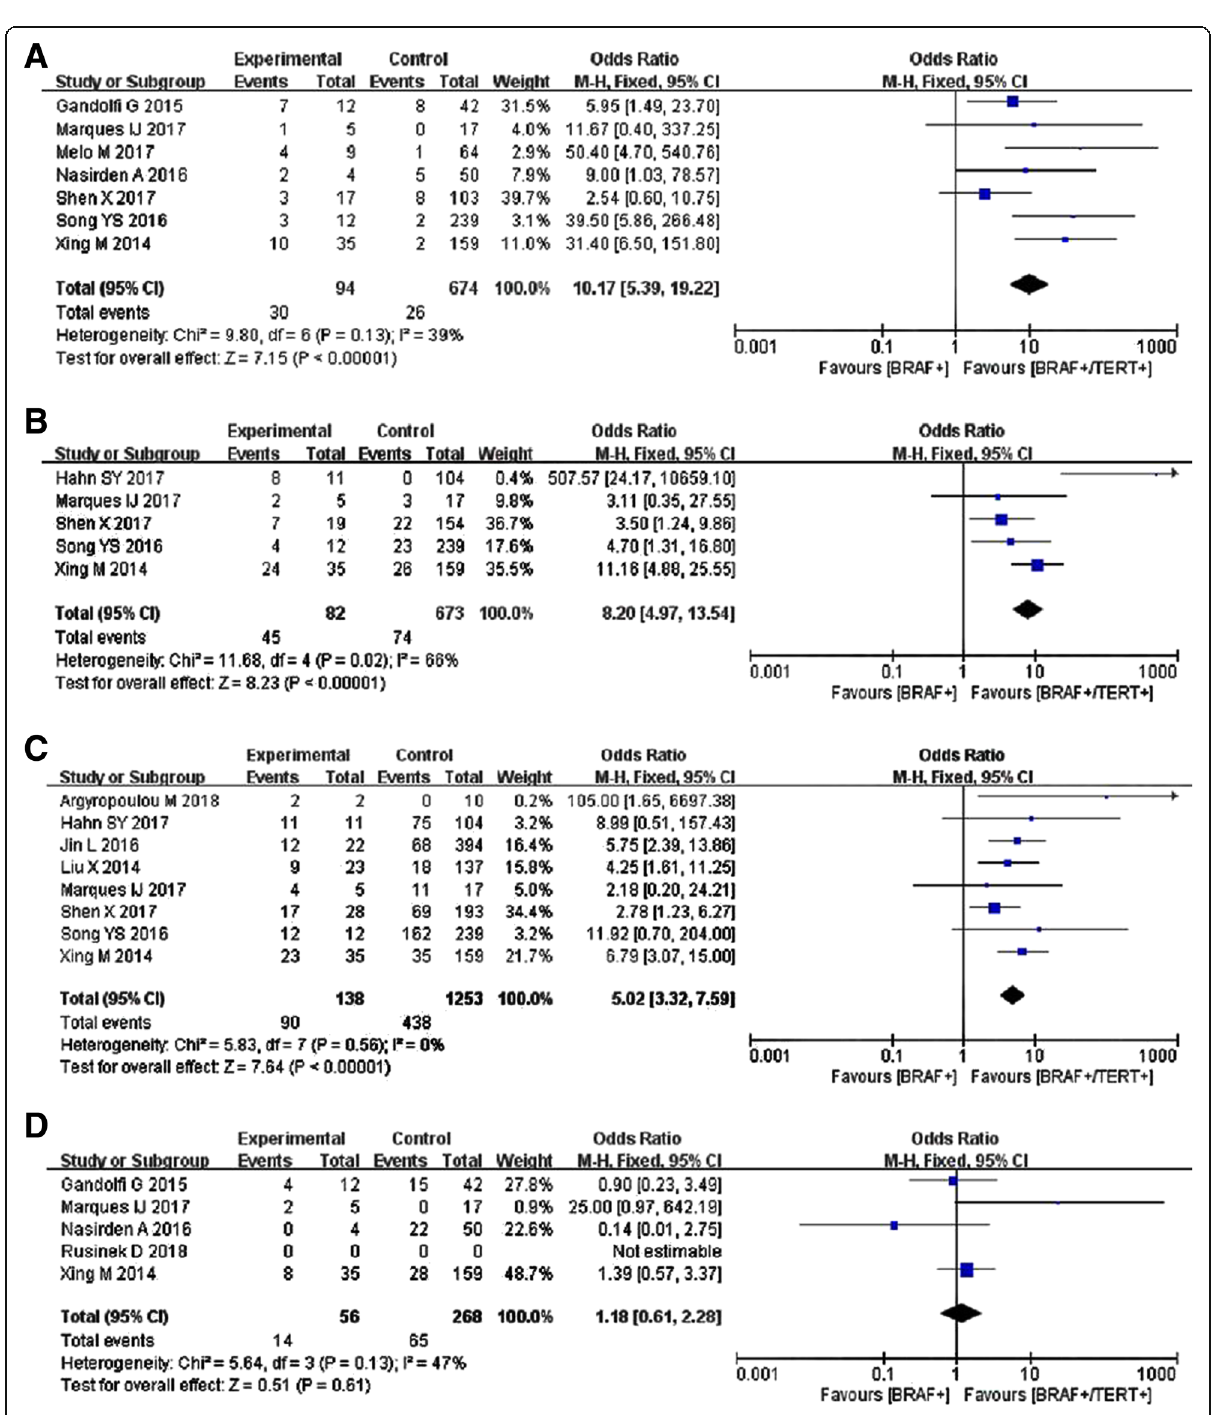
Fig. 3 a Meta-analysis results of the relationship between BRAF V600E/TERT promoter mutations and distant metastasis. b Meta-analysis results of the relationship between BRAF V600E/TERT promoter mutations and tumor recurrence. c Meta-analysis results of the relationship between BRAF V600E/TERT promoter mutations and extrathyroidal extension. d Meta-analysis results of the relationship between BRAF V600E/TERT promoter mutations and vascular